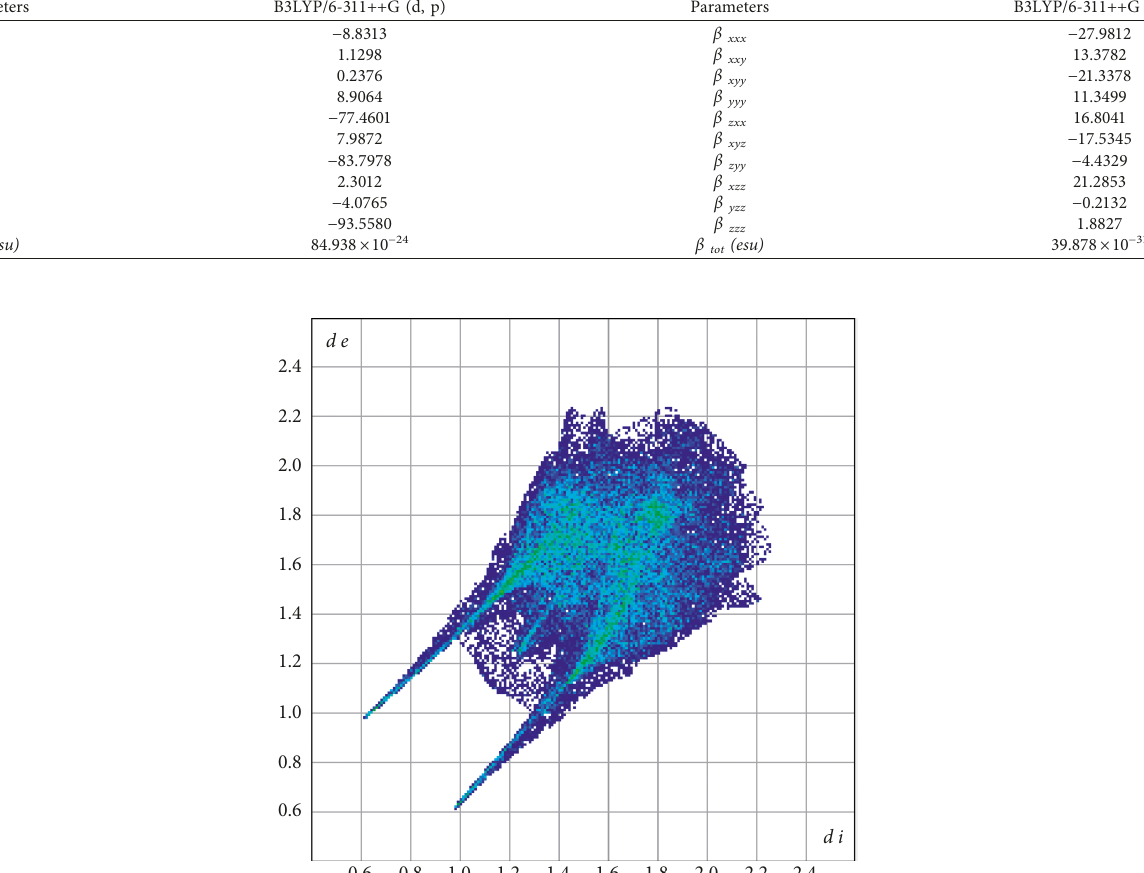
Table 5: Calculated electric dipole moment, polarizability, and first-order hyperpolarizability of 3M2VPP. Parameters